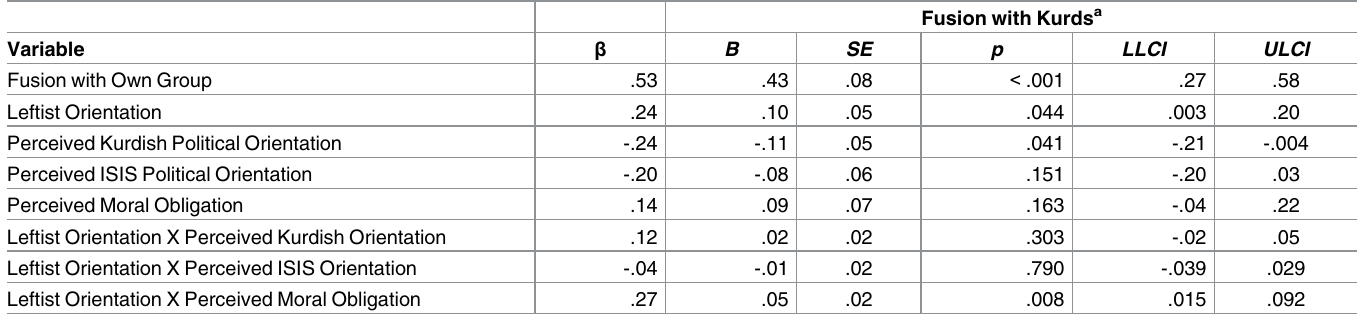
Table 7. Moderated regression models for fusion with the out-group in Study 4 is